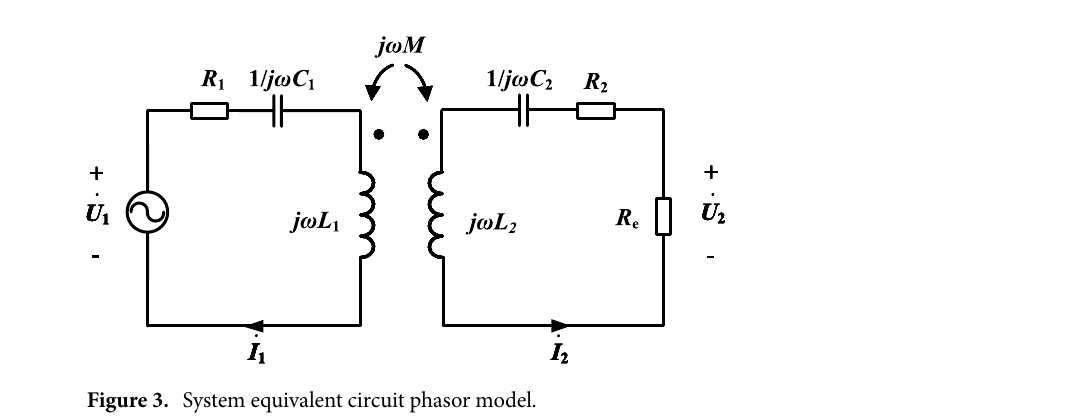
Figure 3. System equivalent circuit phasor